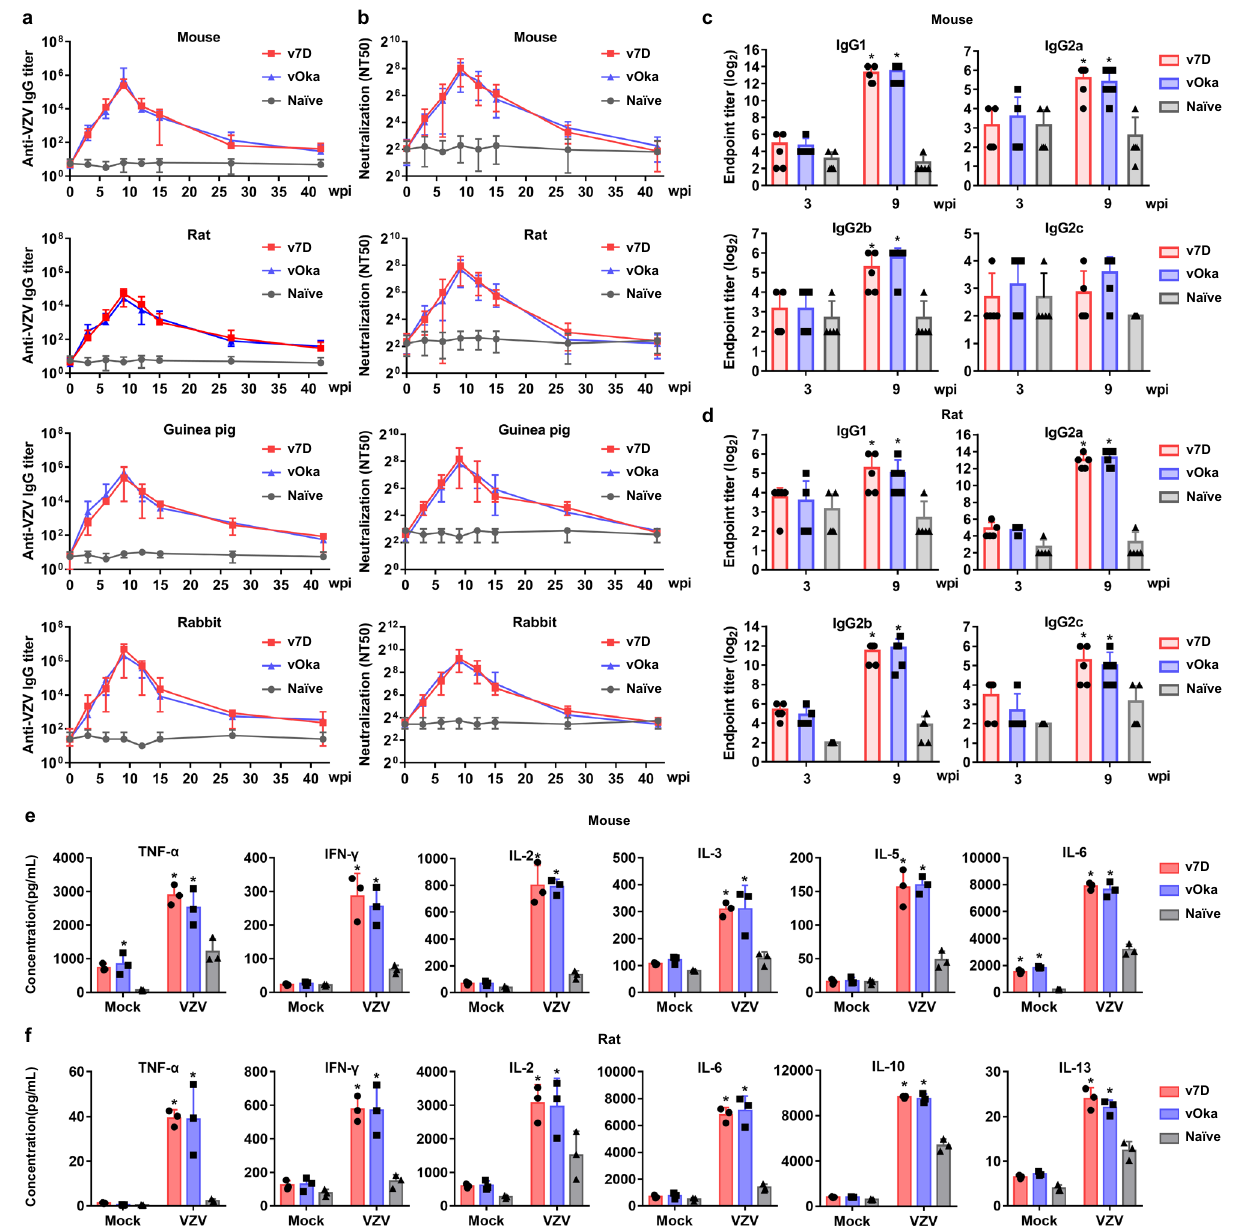
Fig. 5 Antibody and cellular immune responses after v7D immunization in different small animals. Mice, rats, guinea pigs and rabbits were immunized subcutaneously at weeks 0, 3, and 6 with v7D or vOka, at 500 PFU/dose for mice, 1000 PFU/dose for rats, 1000 PFU/dose for guinea pigs and 2000 PFU/dose for rabbits. a , b Serum samples were collected at indicated time points over a 42-week period for evaluation of ( a ) anti-VZV IgG antibody titers and ( b ) the neutralizing antibody titers ( n = 24 per group for mice, n = 18 per group for rats and n = 6 per group for both guinea pigs and rabbits). c , d The IgG subclass distributions (IgG1, IgG2a, IgG2b, and IgG2c) for anti-VZV antibodies were also determined in ( c ) mice and ( d ) rats ( n = 5 per group) 3 weeks after the fi rst (week 3) and third inoculation (week 9). e , f Splenocytes were collected from immunized ( e ) mice and ( f ) rats ( n = 3 per group) at week 9 and stimulated with rOka virus or mock-infected MRC-5 cell lysate as the negative control. Cytokines/chemokines (including Th1 cytokines TNF- α , IFN- γ and IL-2, and Th2 cytokines IL-3, IL-5, IL-6, IL-8, IL-10, and/or IL-13; more in Supplementary Figs. 7 – 8) were quantitated in the culture supernatants by Luminex at 2 dpi. The results are represented as averages ± the SD. Asterisks in ( c – f ) denote a signi fi cant difference ( P < 0.05) compared to the untreated naïve controls as determined by two-way ANOVA with Tukey ’ s post hoc test. Detailed information about the statistics and values are provided in Supplementary Table 3. The experiments were repeated twice, and representative results are shown. Source data are provided as a Source Data fi controls, many of these cytokine/chemokine responses were stimulation, a subset of cytokines representing Th1 (TNF- α , IFN- γ , and IL-2), Th2 (IL-4, IL-5, IL-6, IL-10, IL-13, etc.) and Th17 virus-speci fi c. Furthermore, the cell immune responses sustained at similar levels in both splenocytes and PBMCs from the v7D- (IL-17) responses, as well as chemokines (IP-10, M Ι P-1 β , MCP-1, and vOka-immunized groups until the termination of this study RANTES, etc.) was signi fi cantly upregulated at similar levels in (week 42) (Supplementary Fig. 9 – 12). In addition, immunization splenocytes from the v7D- and vOka-immunized groups (Fig. 5e, with v7D and vOka viruses elicited comparable cellular immune f and Supplementary Fig. 7 – 8). Compared with the mock